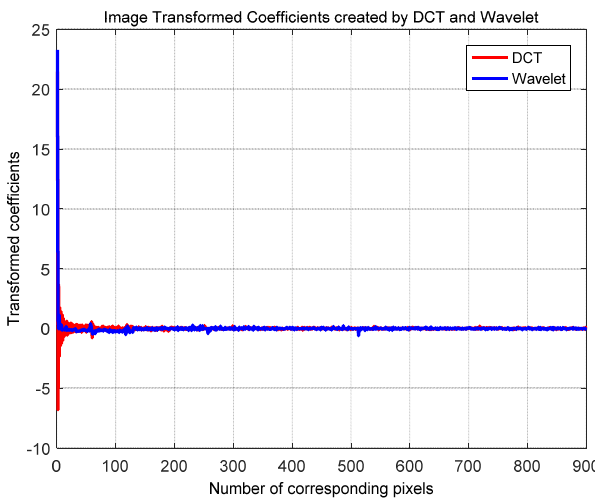
Figure 5. The image is partly transformed by both DCT and Wavelet